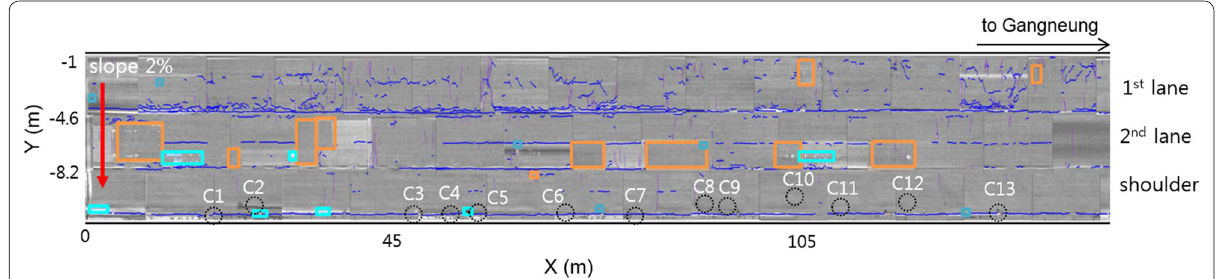
Fig. 4 Surface condition map obtained from the pilot bridge deck, which includes various types of surface damages ( (cid:826) : core, ― : surface‑breaking cracks, □ : efflorescence, □ : patching and □ :